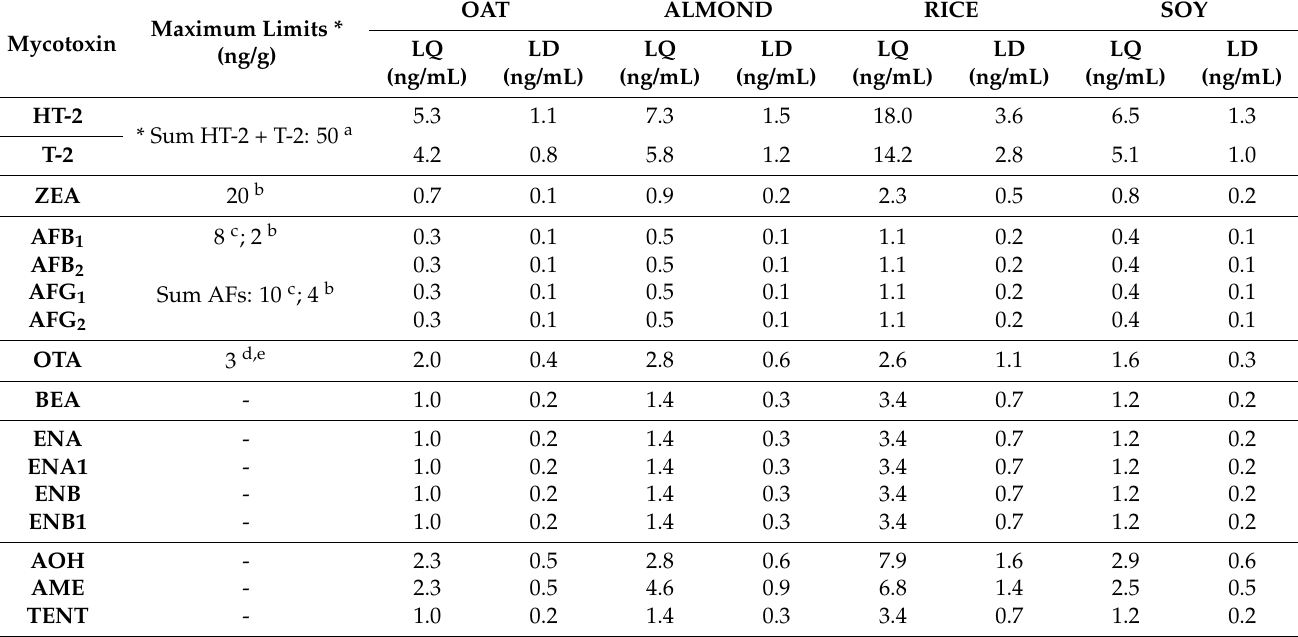
Table 3. Limits of quantification (LQ) and of detection (LD) in the four matrices studied, as well as the maximum limits and recommended values established in the